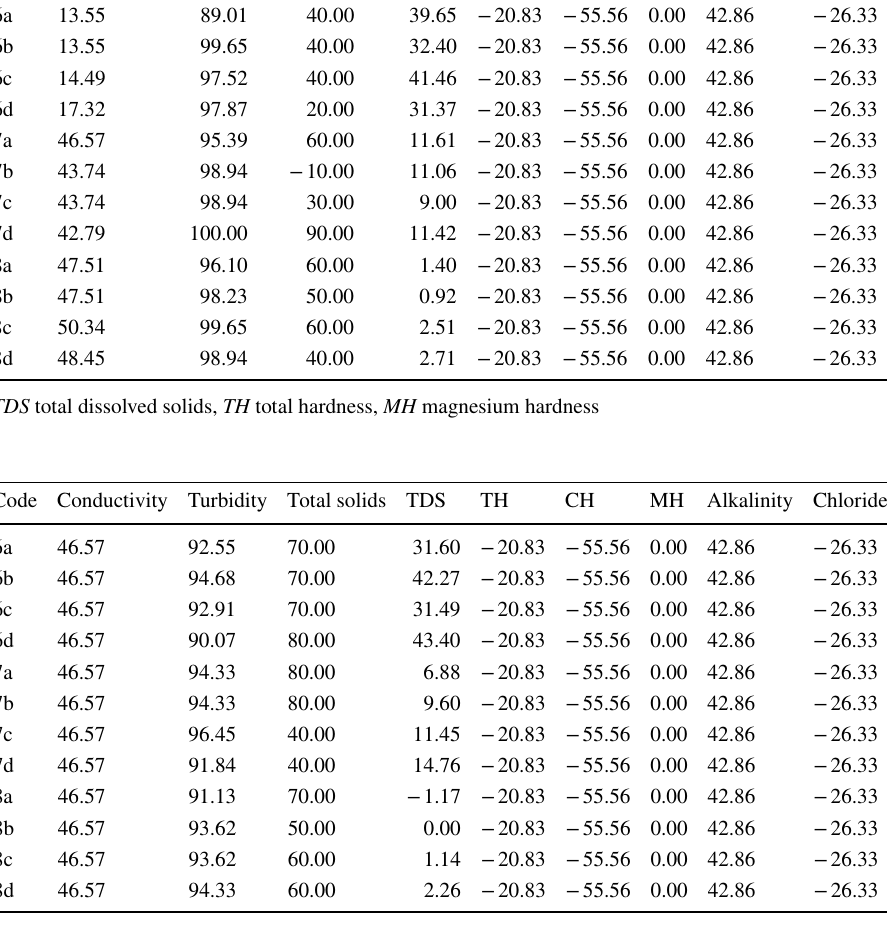
in various physicochemical parameters of surface water after treatment with blended coagulant (alum +